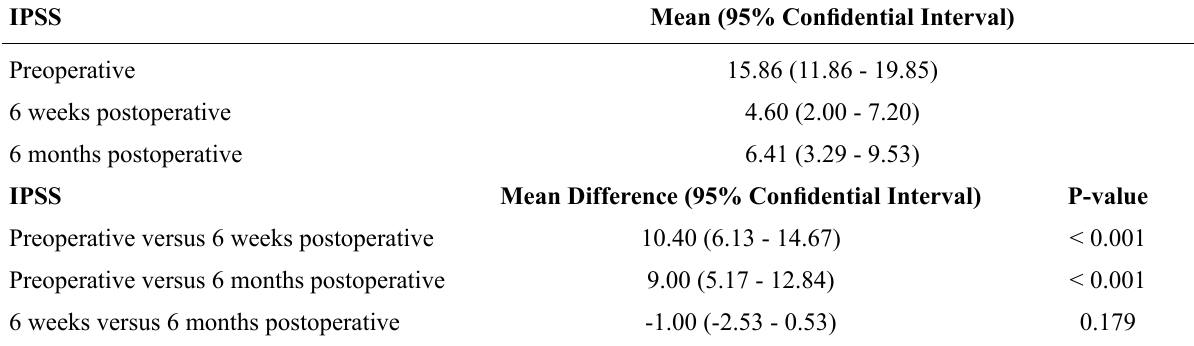
Table 1 - Results